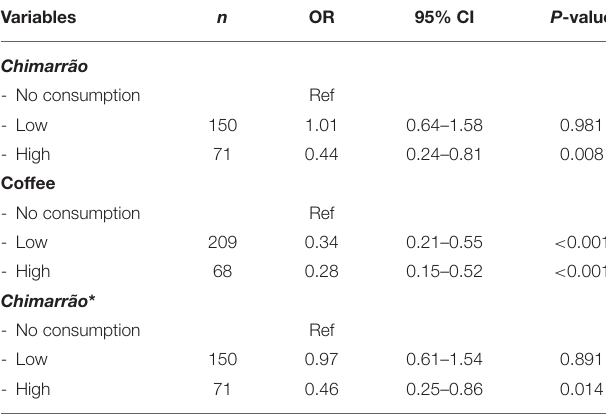
TABLE 3 | Model of chimarrão and coffee consumption adjusted for smoking history and age ( chimarrão low consumption < 6 cuias /day; chimarrão